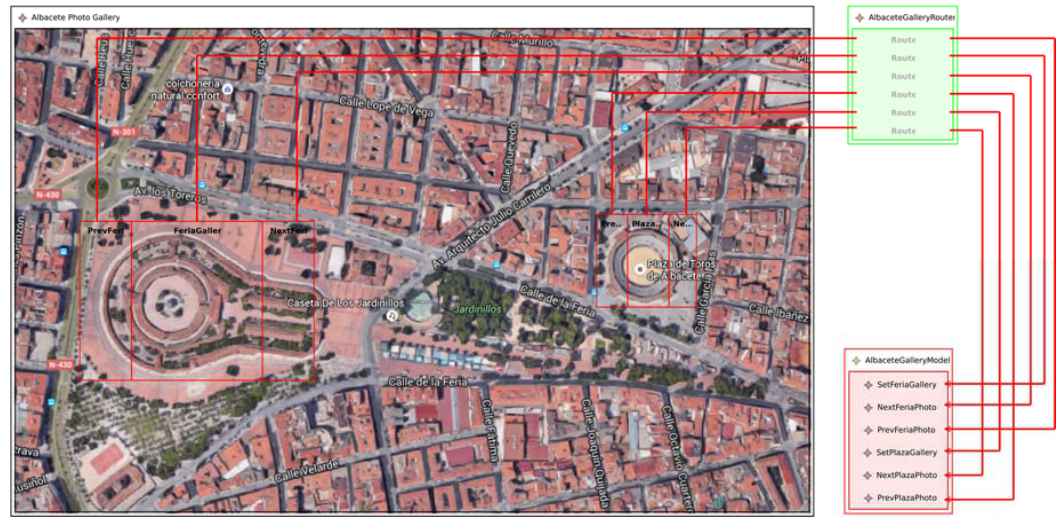
Figure 5. The platform independent model of the Albacete photo gallery application.